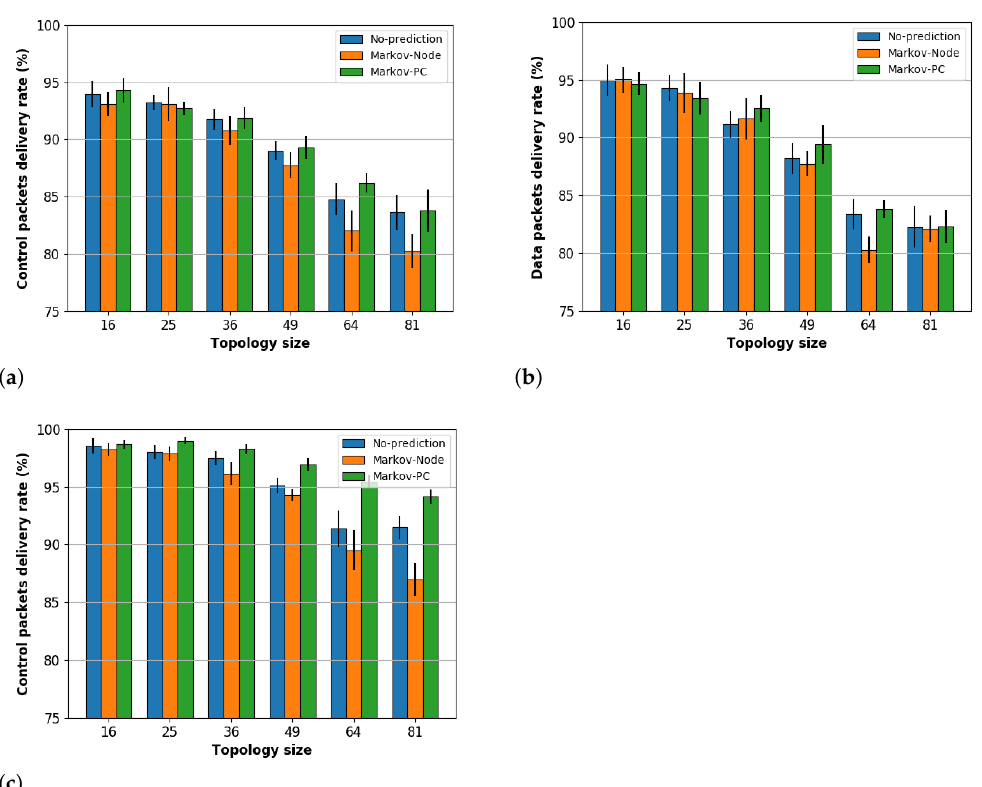
Figure 7. Total Delivery rate of Markov chain and No-Prediction schemes: ( a ) shows the delivery rate of control packets, ( b ) shows the delivery rate of the data packets, and ( c ) shows the delivery rate of energy